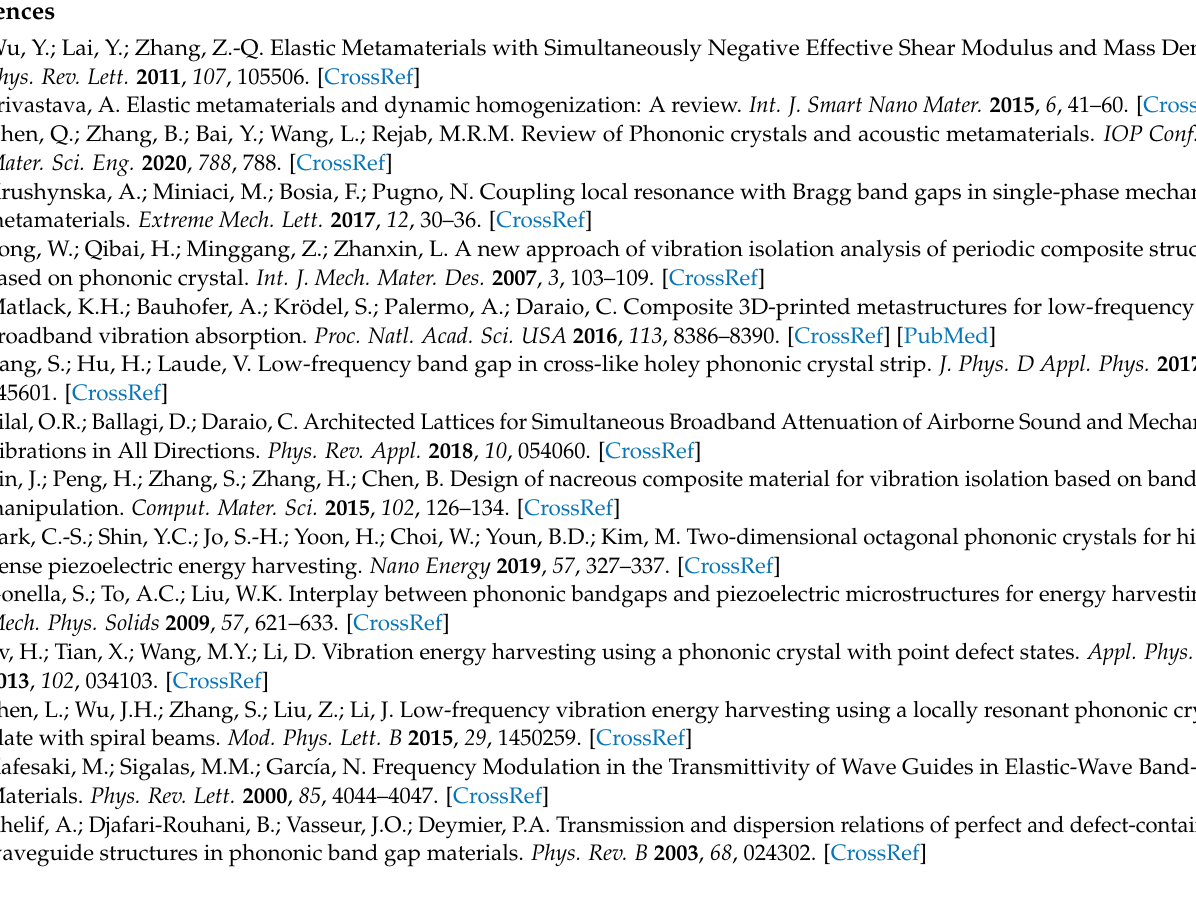
Figure A3. LBF, UBF, and bandwidth versus filling fraction of the phononic crystals with ( a , b ) four inclusions and ( c , d ) nine inclusions.